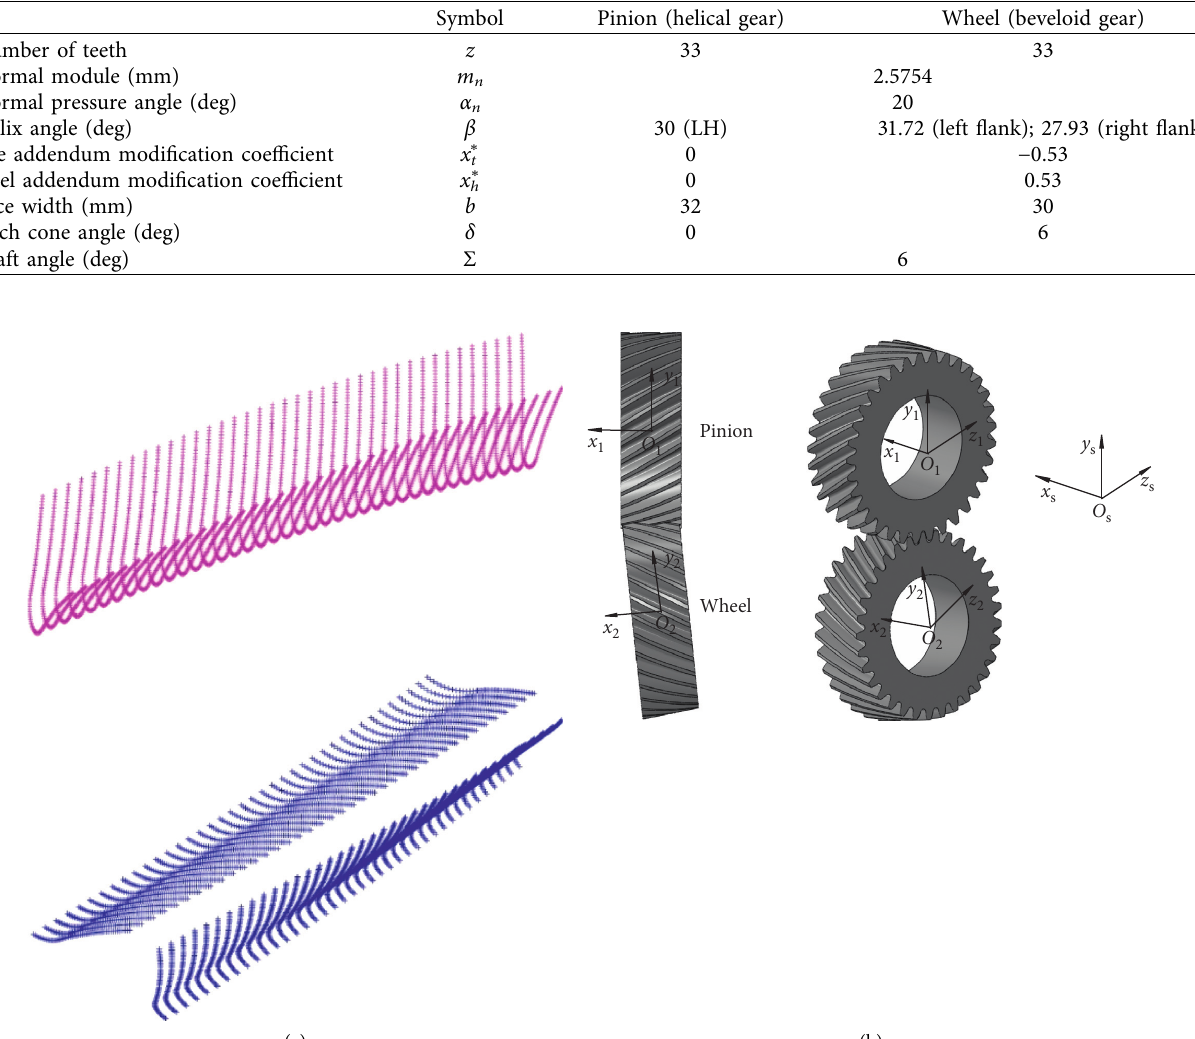
Figure 4: Misalignment conventions of beveloid gear Table 1: The main parameters of beveloid gear pair.